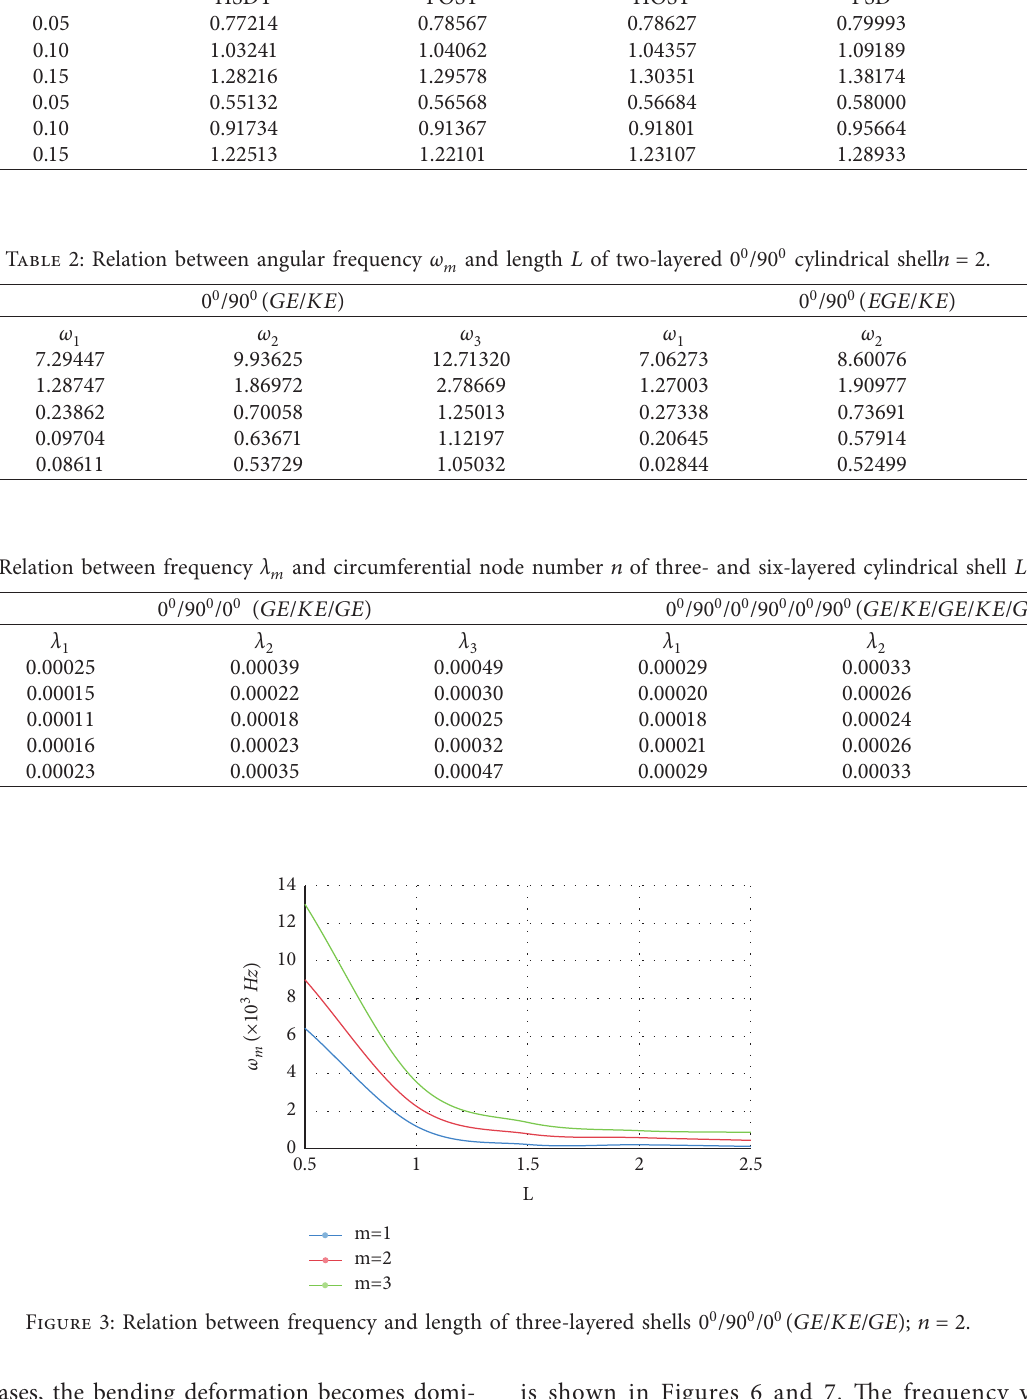
Table 1: The value of frequency parameter λ � ωℓ with Khare et al. [45] ω � ω a / ( ρ / E